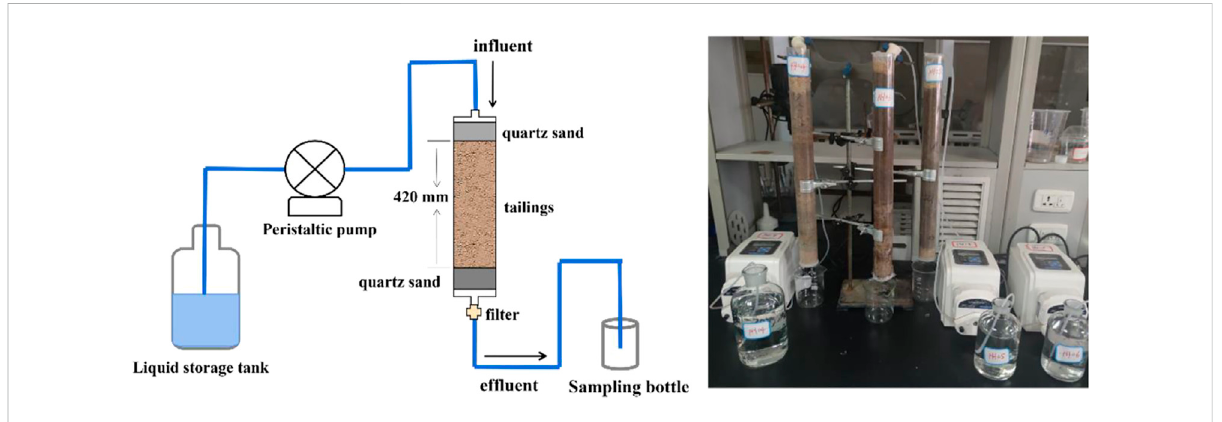
FIGURE 3 Simulated rainfall drenching experiment device.